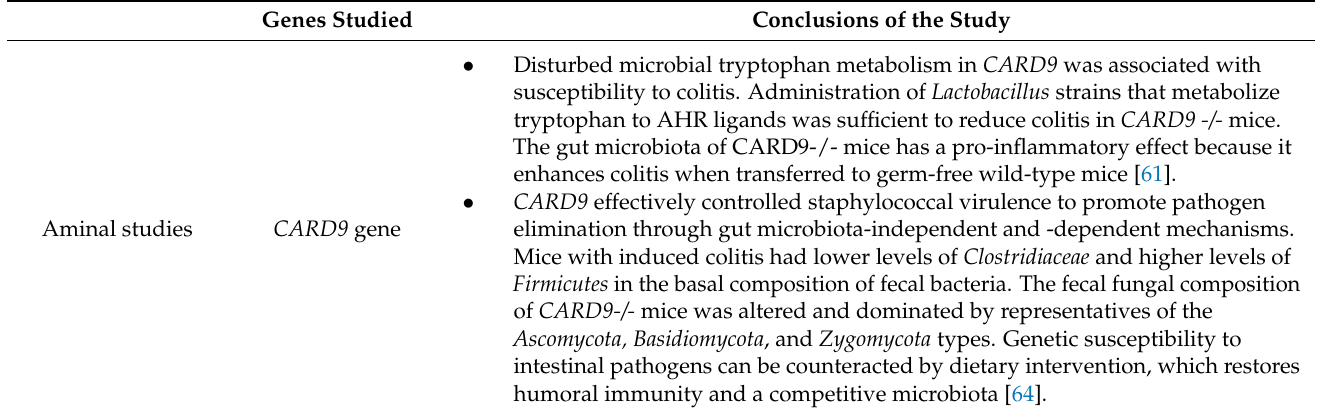
Table 3. The CARD9 gene mutation and its impact on the microbiota in IBD. Genes Studied Conclusions of the Study